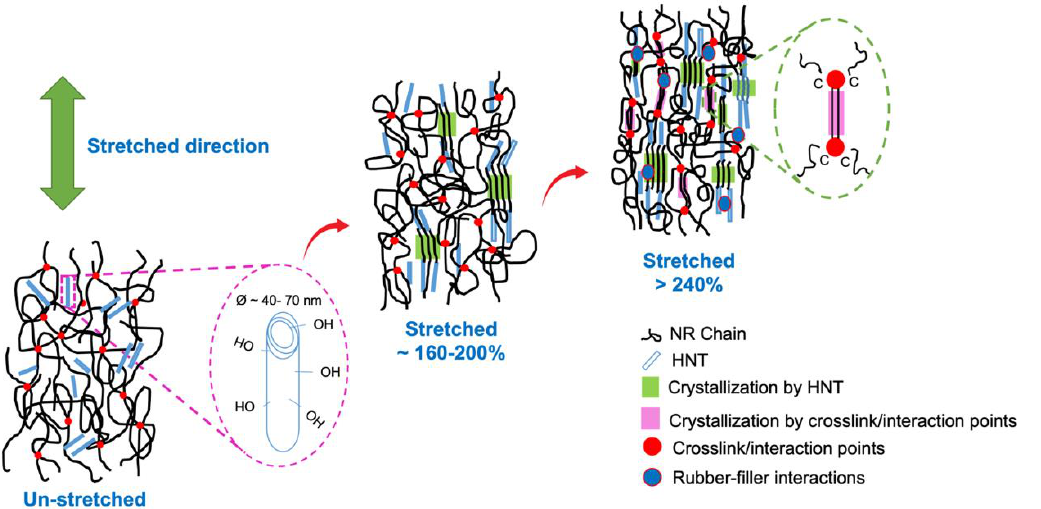
Figure 14. Schematic illustration of SIC in the NR/HNT composites filled with silane coupling